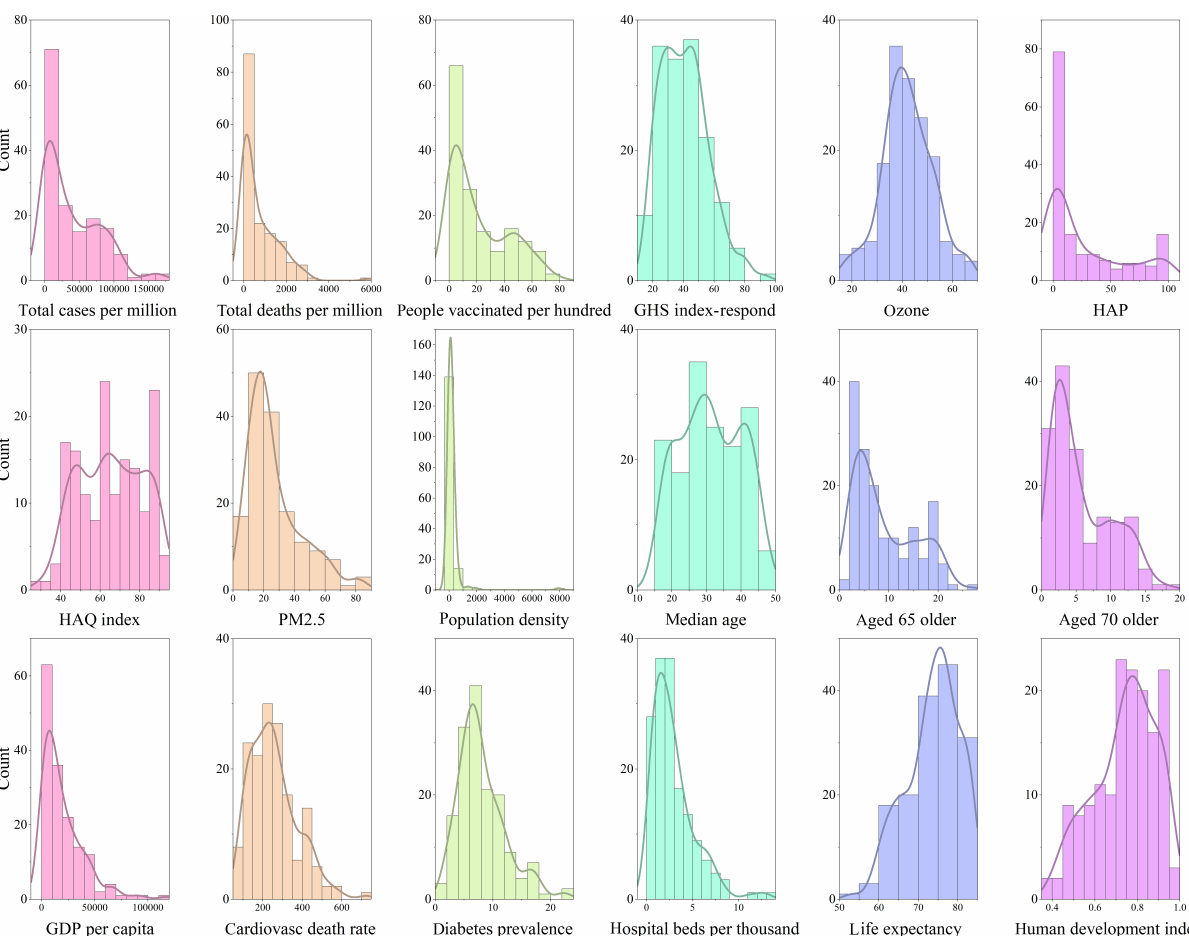
Fig. 5 Histogram distribution of some significant data. Variables such as total cases per million, total deaths per million, and PM2.5 follow a right-skewed distribution; variables including ozone follow a symmetric distribution; HDI follows a left-skewed